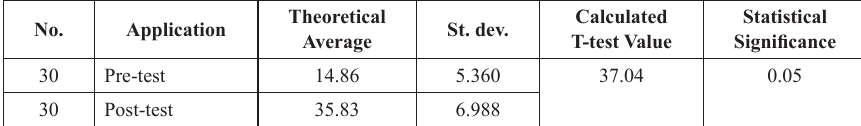
Table 1. The results of the statistical processing of students’ scores in the notecard